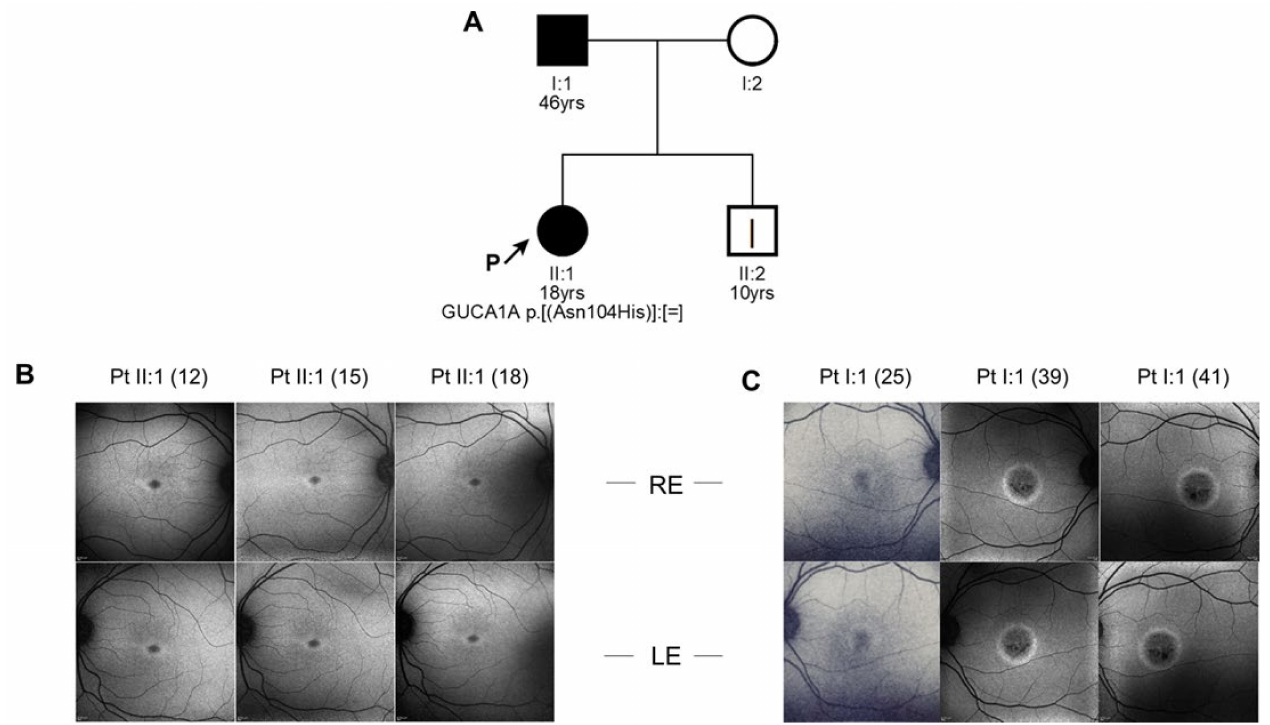
Figure 1. Clinical data and mutation inheritance. ( A ) Pedigree showing the matching genotype–phenotype segregation of the mutant allele of GUCA1A , harboring the c.310A > C mutation causing the amino acid substitution N104H. Legend: square, male subject; circle, female subject; black symbol, affected subject; white symbol, healthy subject; yrs, subject age at his/her last clinical evaluation; P, proband; square brackets ([;];[;]), maternal and paternal chromosome; =, no change; |, sub-clinic phenotype. Fundus images of ( B ) patient II:1 (age 12, 15, 18) and ( C ) patient I:1 (age 25, 39, 41)’s right (upper panels) and left eyes (lower